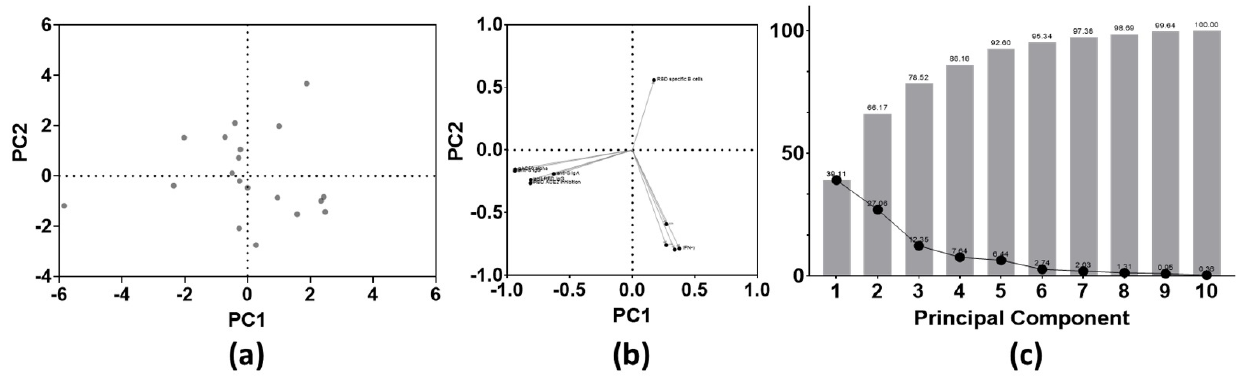
Figure 6. Principal component analysis of both SARS-CoV-2-specific B and T cell parameters at 10 months post-BNT16b2 vaccination ( n = 10 parameters). ( a ) PC scores plot; ( b ) loadings plot; ( c ) proportion of variance graph. Abbreviations: PCA = principal component analysis, PC = principal component.